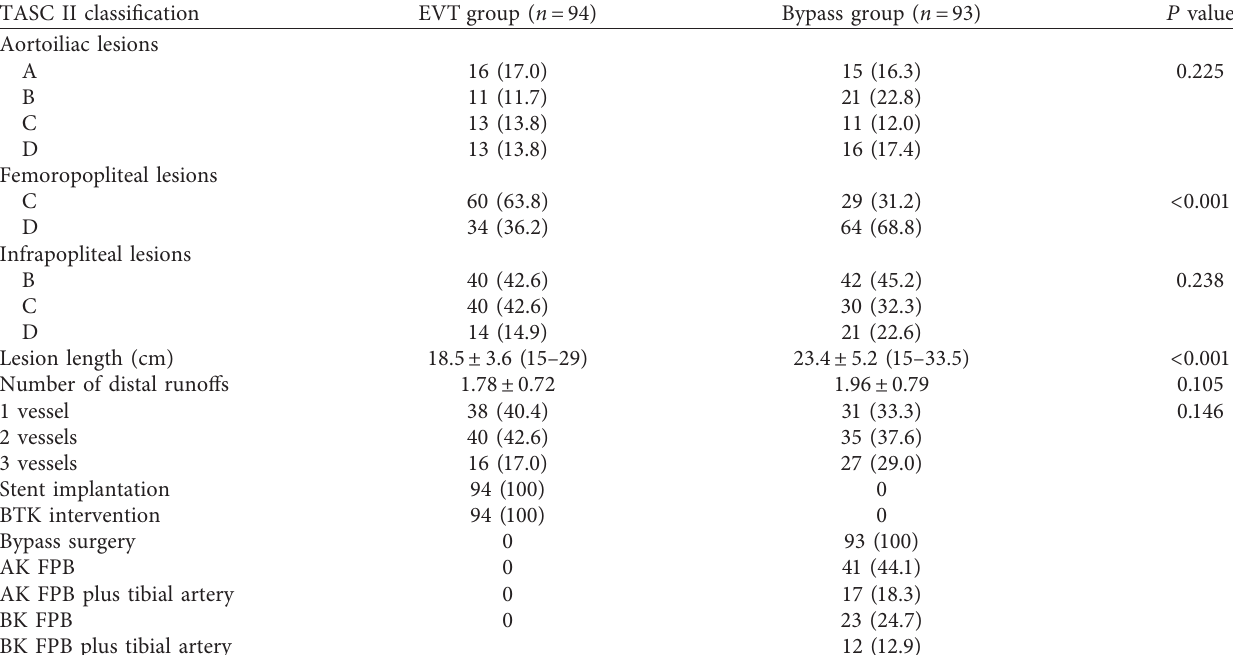
Table 2: Summary of TASC lesions, distribution of diseased vessels, and interventional characteristics.